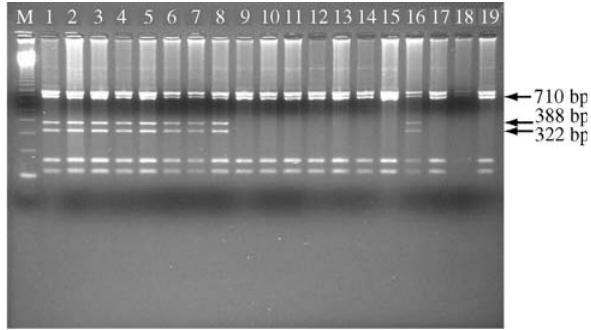
Figure 1 - RsaI polymorphisms in the PIT1 gene detected by PCR-RFLP. The PCR products were run on 2% agarose gels. M - 100 bp ladder of mo- lecular weight markers (Gibco/BRL); lanes 1 - 8 and 16 show the AB ge- notype;lanes9-15and17-19showtheAAgenotype.AlleleAcontained a 710 bp fragment whereas allele B had two fragments, 388 and 322 bp, thatareindicatedbyarrows.Monomorphicfragmentsof774,153and108 bp were also present.